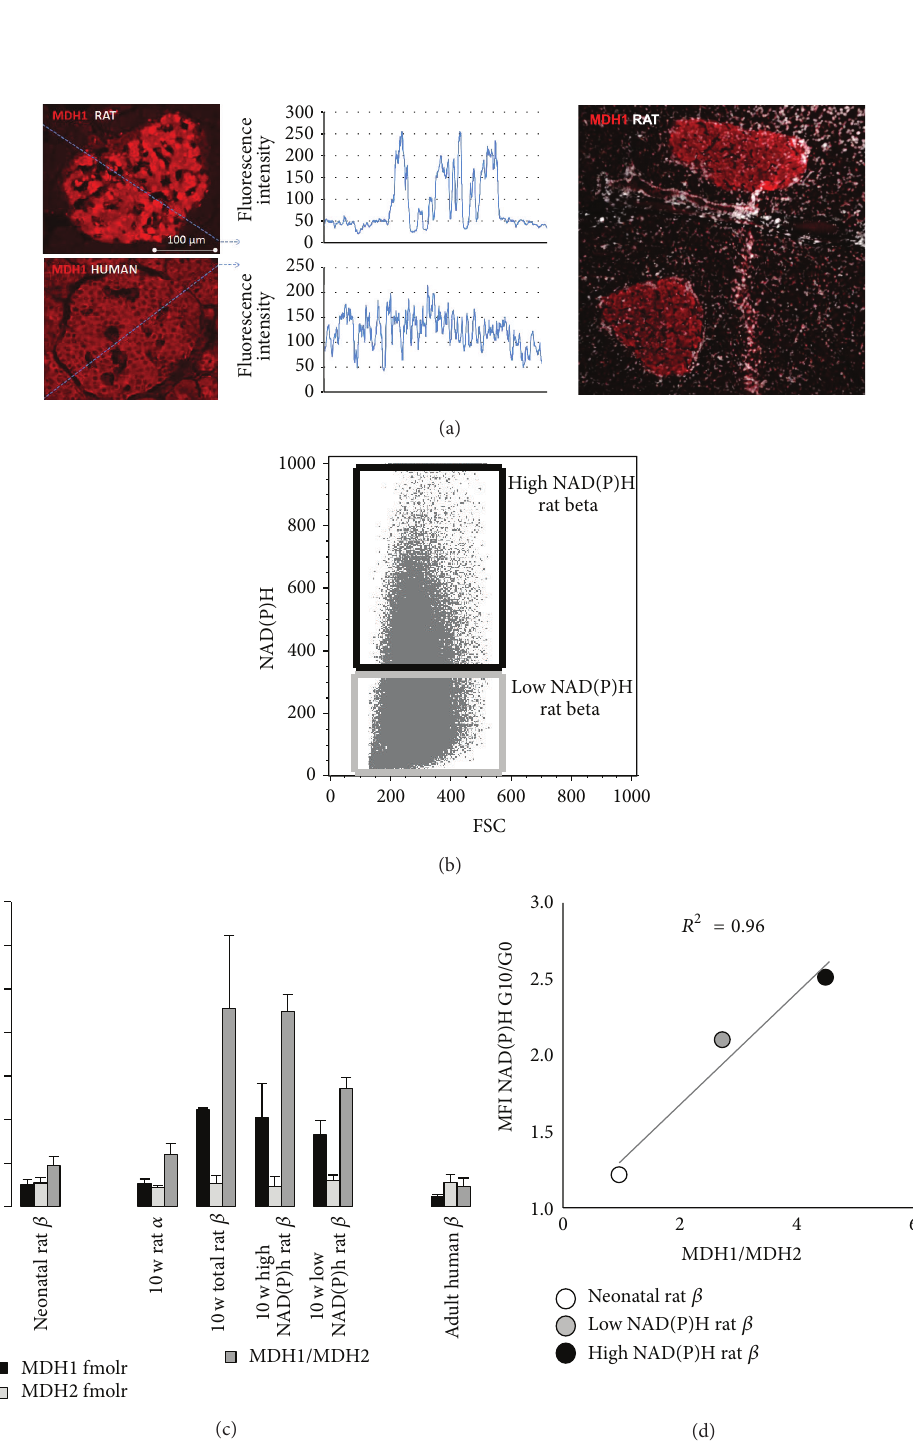
Figure 3: Beta cell-selective MDH1 expression in rat but not human pancreas. (a) A monoclonal antibody raised against recombinant human MDH1 fragment results in islet-restricted staining pattern in rat pancreas. In human pancreas, MDH1 fluorescence in islets does not exceed background level of surrounding exocrine tissue, as evidenced by intensity plotted along the dotted blue line, while in rat it shows a strong islet-restricted level. Representative of 3 organs analyzed for each species. (b–d) In rat, cellular MH1/MDH2 level increases during postnatal beta cell maturation from neonatal period to 10 weeks (c). In 10-week-old cells, beta cells FACS-sorted (b) for higher 7.5 mM glucose-induced NADH have higher MDH1/MDH2, and overall (d), the increment of cellular NADH acutely after 10 versus 0 mM glucose-stimulation is linearly correlated to cellular MDH1/MDH2 in the indicated rat beta cell